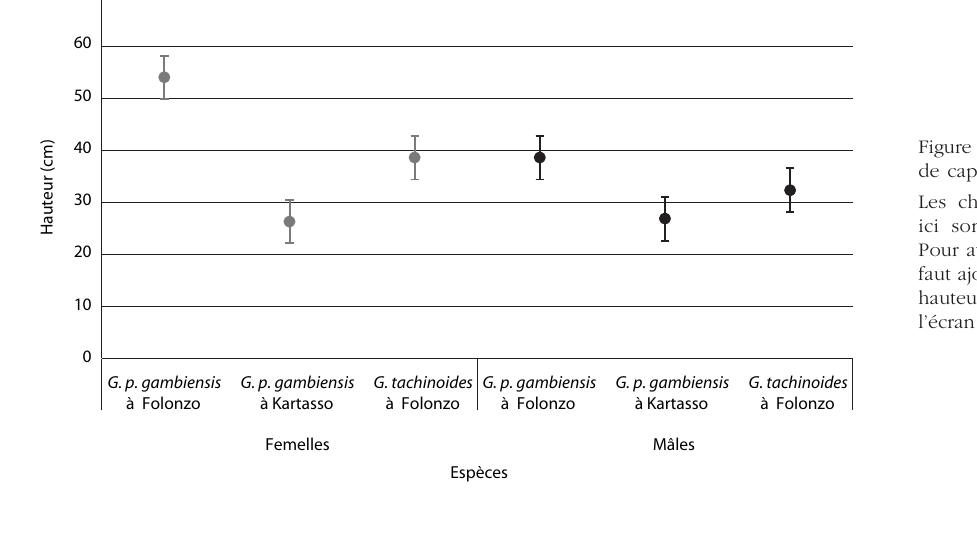
Figure 2. – Comparaison de la hauteur de capture selon l’espèce et le sexe. Les chiffres de hauteur représentés ici sont ceux mesurés sur l’écran. Pour avoir la hauteur réelle de vol, il faut ajouter 20 cm qui représentent la hauteur à laquelle la partie basse de l’écran est posée au-dessus du sol.